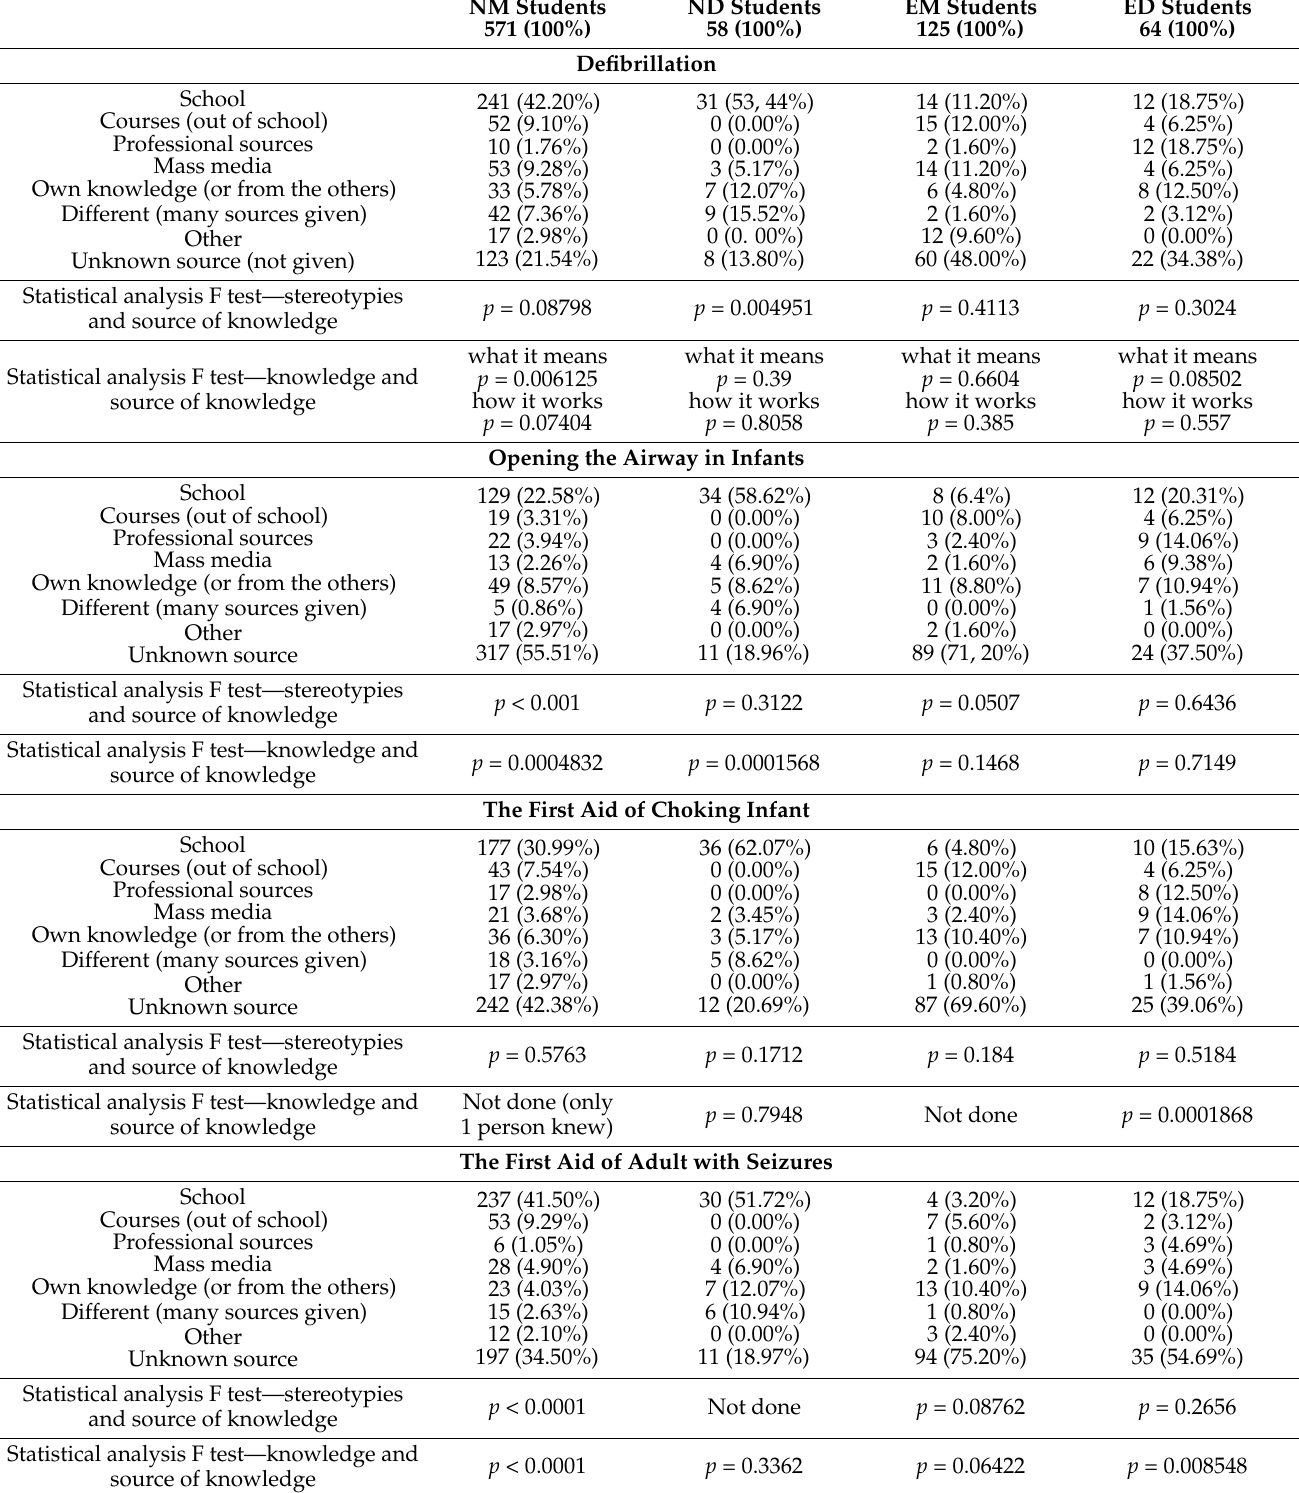
Table 3. The sources of knowledge to each question and statistical